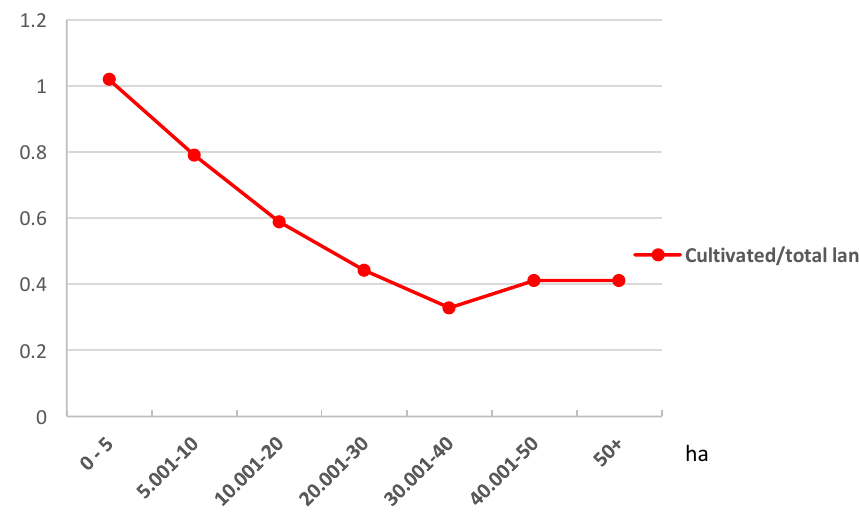
Figure 4. Cultivated land vs. total landholding ratio for the different farm size categories ( N = 300).